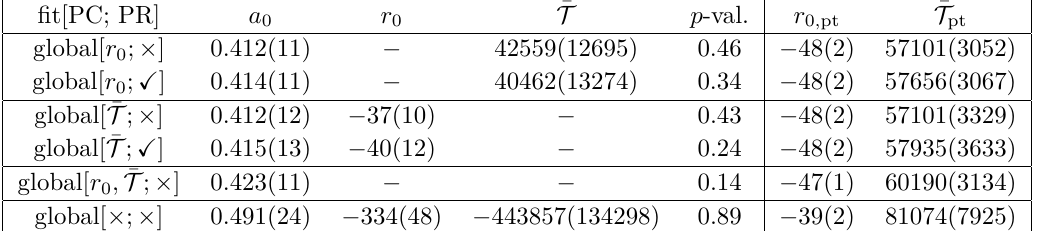
Table 8. Results from the different energy shift fits with perturbative constraints (PC). Both fixed- N fits ( ∆ E N , N = 2 , 3 , 4 , 5 ) and global fits to order L − 6 are listed, without as well as with a 0 priors (PR), obtained from the respective ∆ E 2 [ r 0 ; × ] -fit. In case of combined fits without a 0 priors, ∆ E 2 contributes, in contrast to global fits with priors. All fits are performed in the interval [12 , 24] for L , and they include EC as well as RC. The perturbative predictions r 0 , pt and ¯ T pt are calculated from eqs. (4.10) and (4.11), using the corresponding values of a 0